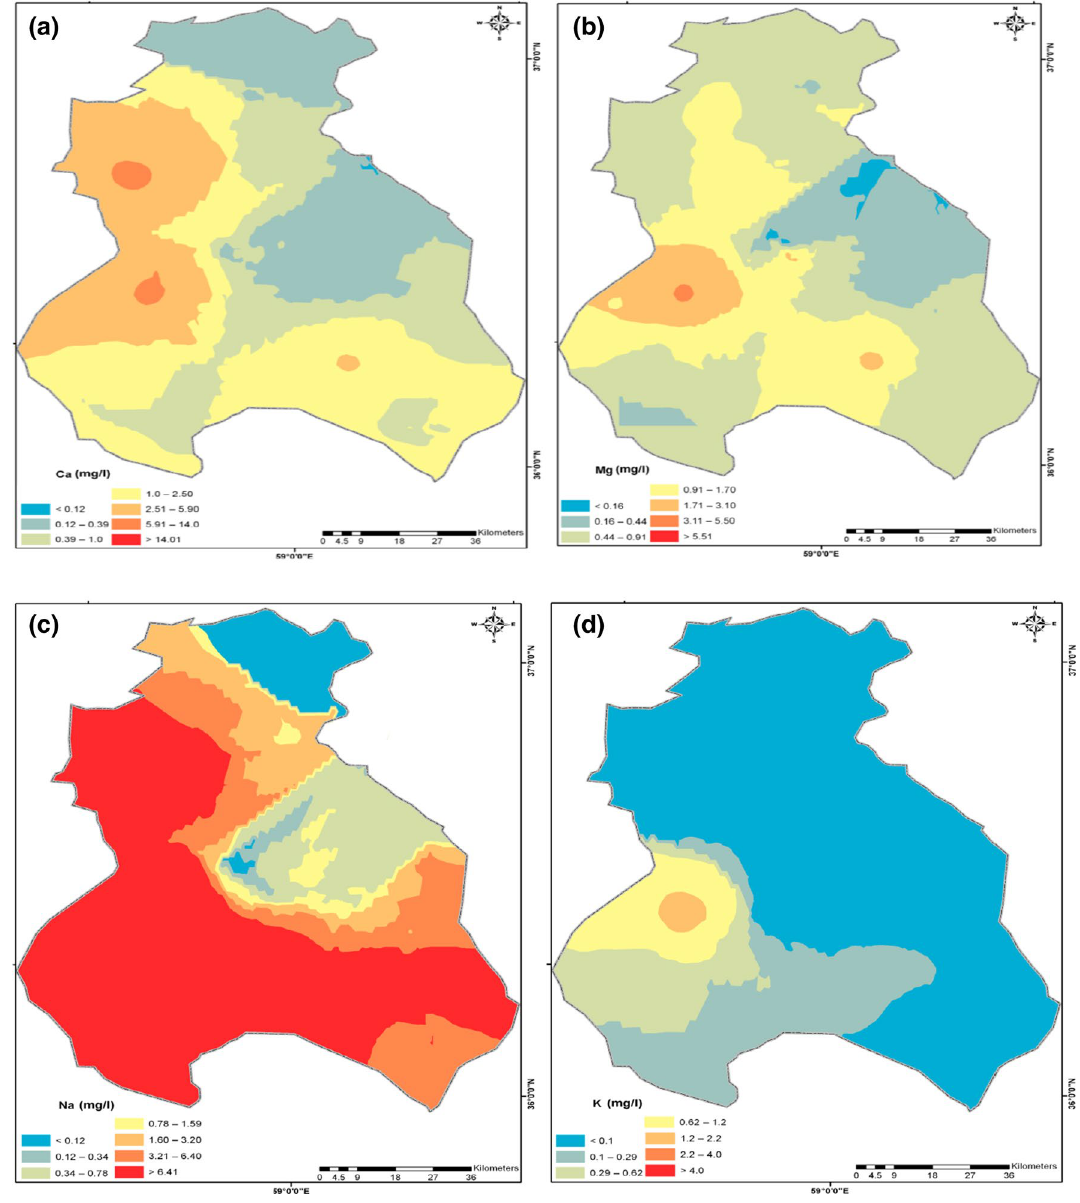
Fig. 3 Spatial distribution of cations a Calcium (Ca 2+ , mg/l). b Magnesium (Mg 2+ , mg/l). c Sodium (Na + , mg/l) and d Potassium (K + ,